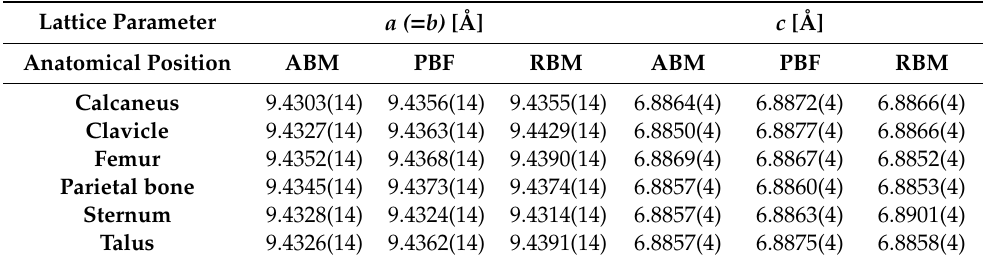
Table 1. Lattice parameters a ( = b) and c of the hexagonal unit cell of human bone bioapatite determined from the Rietveld refinement of XRPD data from human bone analyzed with internal standard NIST LaB 6 . Error is given as the maximum di ff erence observed between lattice parameters calculated from structure refinement using Rietveld refinement versus whole-pattern fitting with constant scale factor. Error values are indicated in the